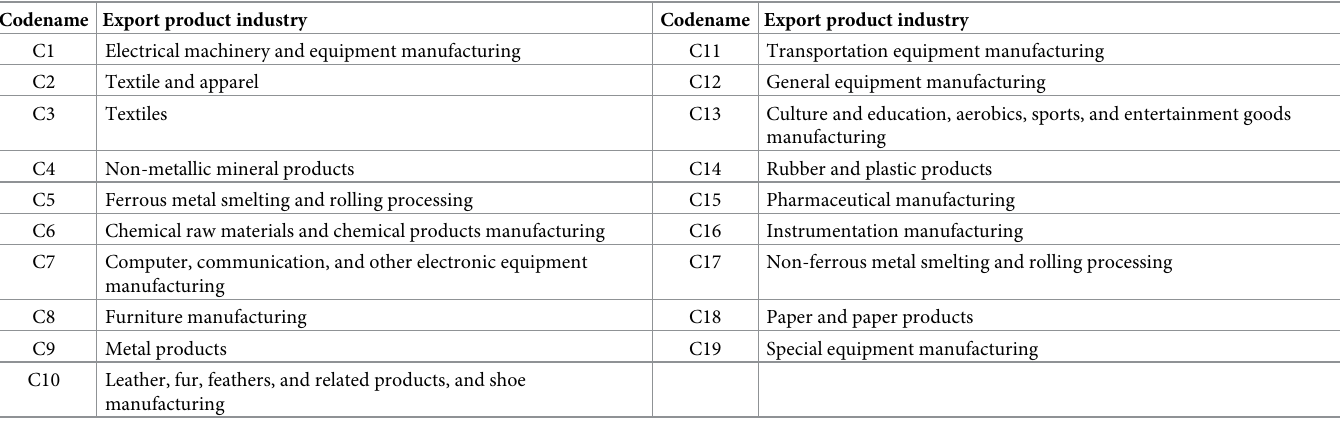
Table 1. Industries of Guangdong Province’s export products.